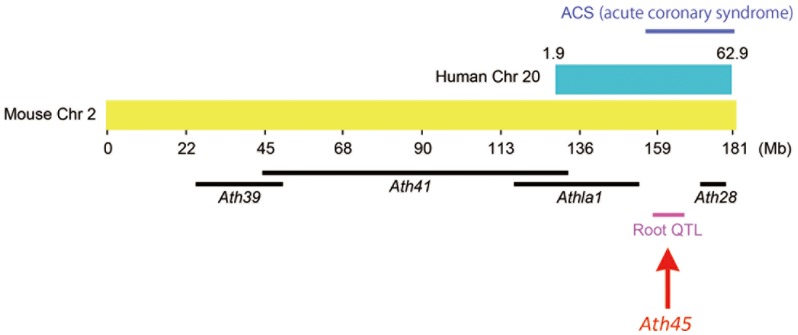
Comparative genomic map of mouse Chromosome 2.Mouse Chr 2 and homologous human Chr 20 regions are derived from the Virtual Comparative Map (VCMap) tool. The black bars represent confidence intervals of previously identified QTL for atherosclerosis; the magenta bar represents Ath45; the blue bar represents the human locus linked with acute coronary syndrome (ACS).